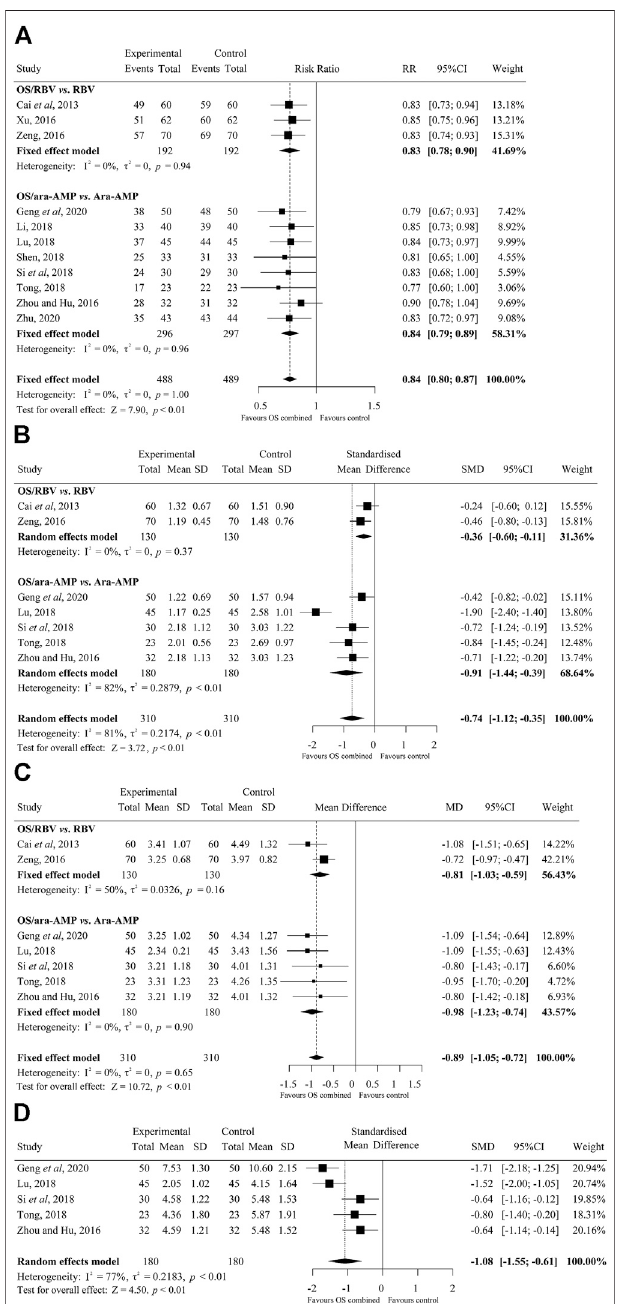
FIGURE 3 | Forest plots of the ef fi cacy of oseltamivir (A) Total effective rate, (B) fever clearance time, (C) rash regression time, and (D) clinical cure time. M-H, Mantel-Haenszel; CI, con fi dence interval; df, degrees of freedom; SD, standard difference; IV, inverse